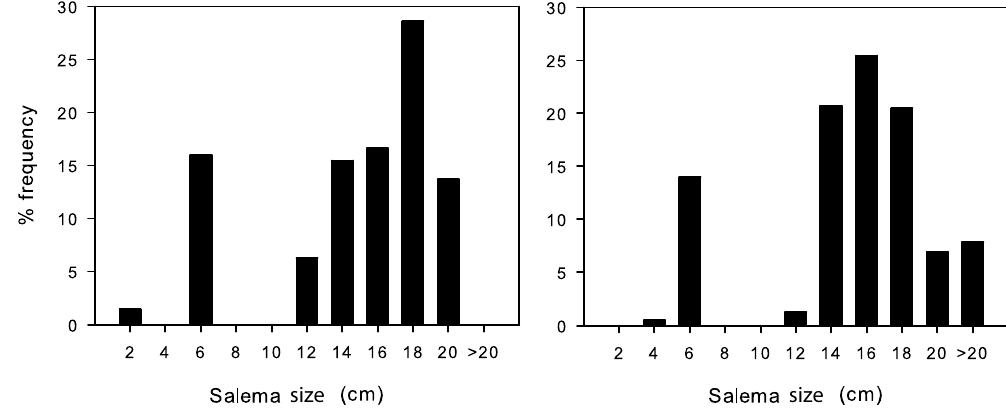
Figure 3. Size class distributions of Sarpa salpa . Percentage frequency of salema individuals per size recorded in the two visual census performed during the